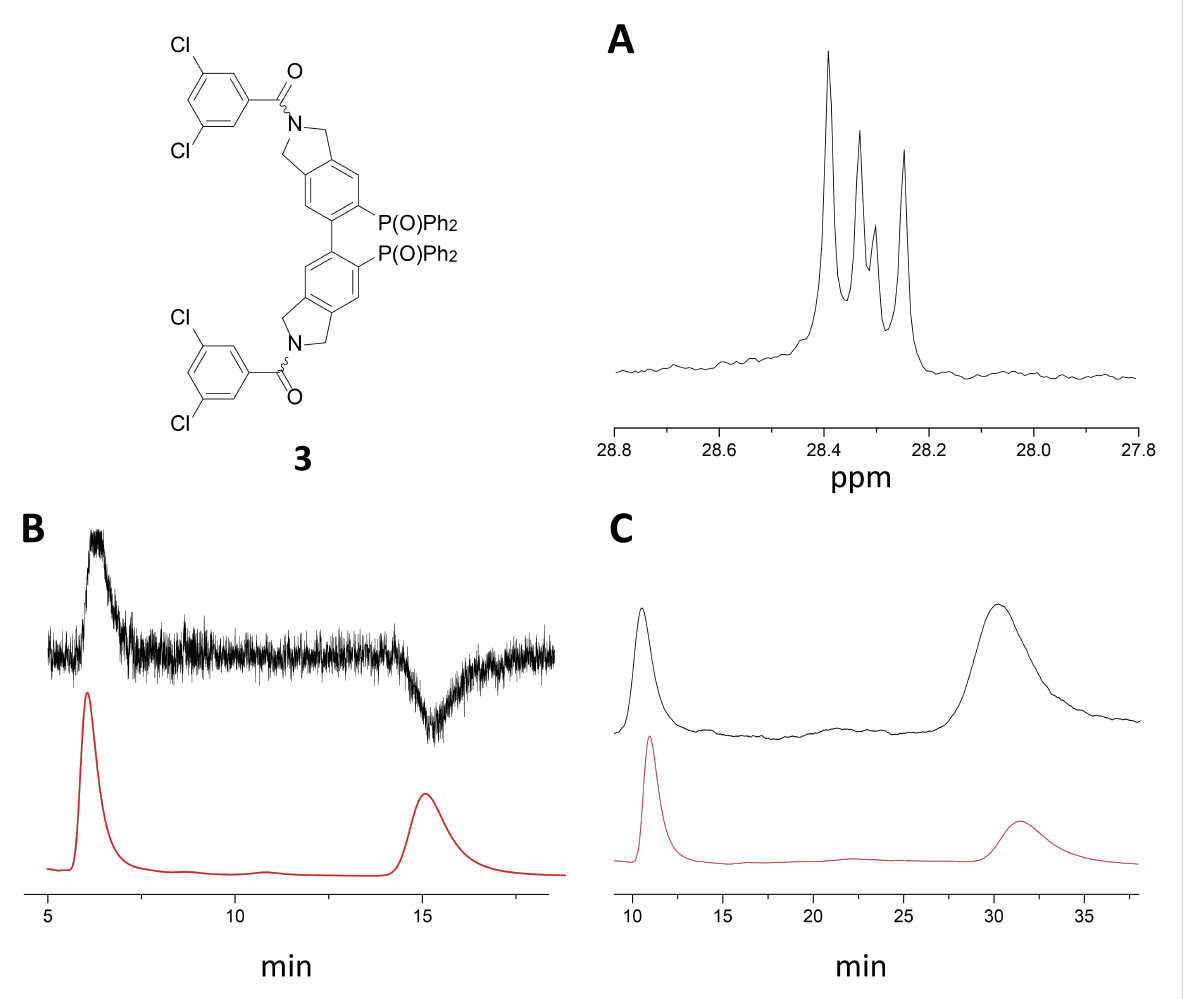
Figure 2: Investigation of 3,5-dichlorobenzoyl modified tetrahydrobiisoindole “NU-BIPHEP(O)” 3 . A) Three signal sets are observed in 31 P{ 1 H} NMR spectroscopy (CDCl 3 ). B) HPLC–CD chromatogram ( n -hexane/2-propanol 50:50, CHIRALPAK ® IA-3, 1 mL/min, 20 °C). Red: UV trace, black: CD trace. C) On-column deracemization of 3 ( n -hexane/2-propanol 50:50, CHIRALPAK ® IA). Chromatogram with (black) and without (red) the